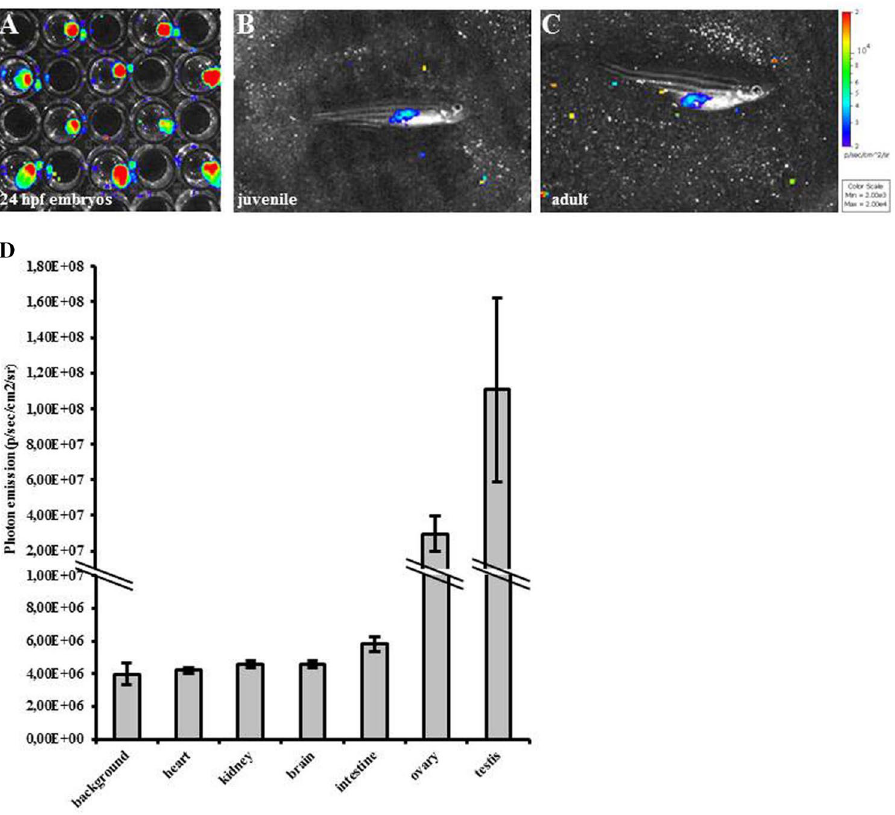
Figure 3. Bioluminescence correlates with proliferation in MITO-Luc/GFP zebrafish line. ( A–C ) In vivo BLI of representative MITO-Luc/GFP 1 zebrafish embryos (1 embryo for each well) ( A ), juvenile ( B ) and adult ( C ) stages. Light emitted from the animal appears in pseudocolor scaling. ( D ) Photon emission quantification of organs extracted from adult zebrafish. The error bars are mean standard deviations from six samples for each